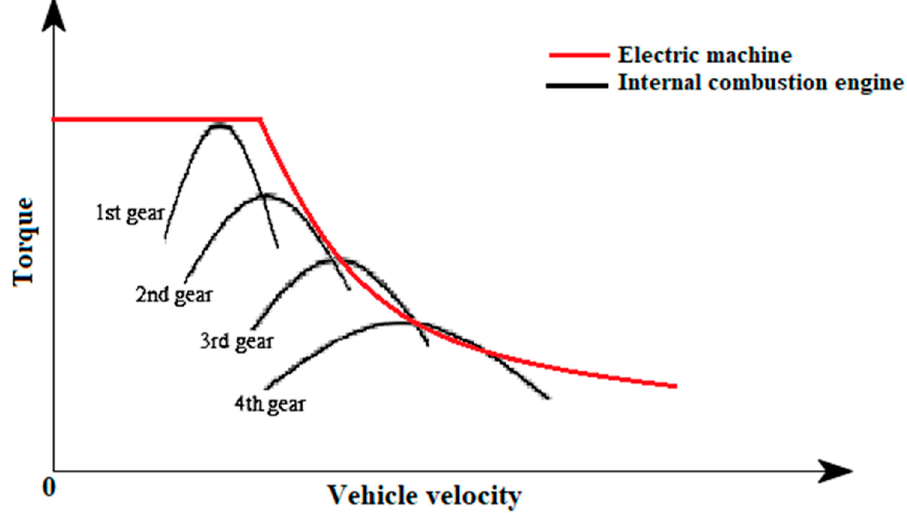
Figure 4. Torque-speed characteristics of electric machine and internal combustion engine.